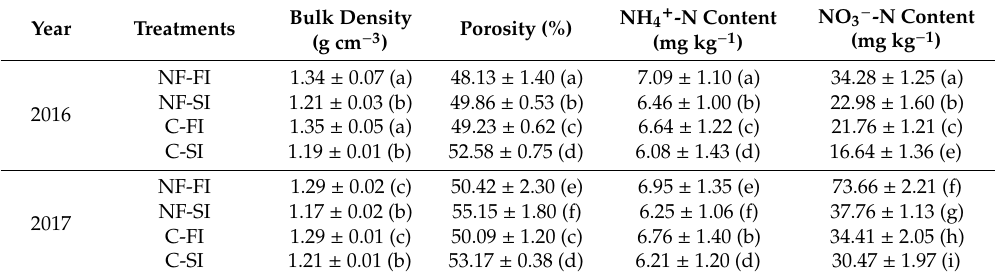
Table 3. Basic physical and chemical properties of soil under the two irrigation systems and for di ff erent fertilization treatments in 2016 and